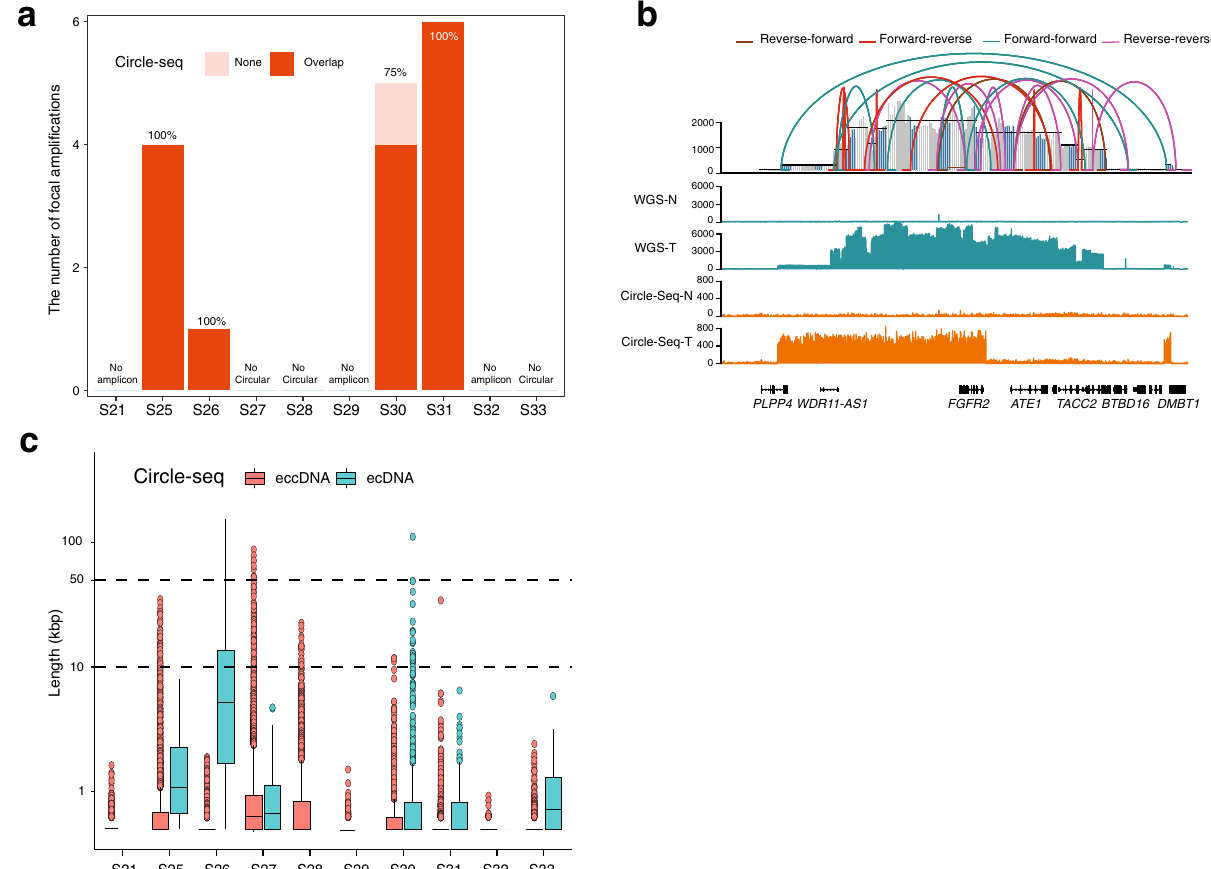
Fig. 2 Validation of the ecDNA amplicons using Circle-seq. a Summary of ecDNA overlapping lists from the prediction of AmpliconArchitect (AA) and identi fi cation using Circle-seq. The y -axis is the ecDNA amplicon number from WGS prediction. Overlap: the ecDNA amplicons were identi fi ed using both AA software from WGS and Circle-Seq. None: the ecDNA amplicons were only identi fi ed using AA software but not using Circle-Seq. b The genome browser track at the FGFR2 gene locus from whole-genome sequencing (WGS) and Circle-seq. The connection lines on the top represent the potential structure combination in ecDNA amplicons predicted by AA software. N normal tissue, T tumor tissue. c Circular DNA elements identi fi ed from Cricle-Seq were separated into ecDNA (copy number ≥ 7) (The number of ecDNA, n = 0, n = 41, n = 42, n = 216, n = 0, n = 0, n = 714, n = 261, n = 0, n = 222 for S21, S25, S26, S27, S28, S29, S30, S31, S32 and S33, respectively) and extrachromosomal circular DNA (eccDNA) ( copy number < 7) (The number of eccDNA, n = 1757, n = 7264, n = 4813, n = 38,804, n = 3610, n = 572, n = 2177, n = 3420, n = 481, n = 1686 for S21, S25, S26, S27, S28, S29, S30, S31, S32 and S33, respectively). The box plots show the minima (bottom dot), the maxima (top dot), the median (middle line) and the fi rst and third quartiles (boxes), whereas the whiskers show 1.5× the interquartile range IQR above and below the box. Source data are provided as a Source Data fi le for Fig. 2a –